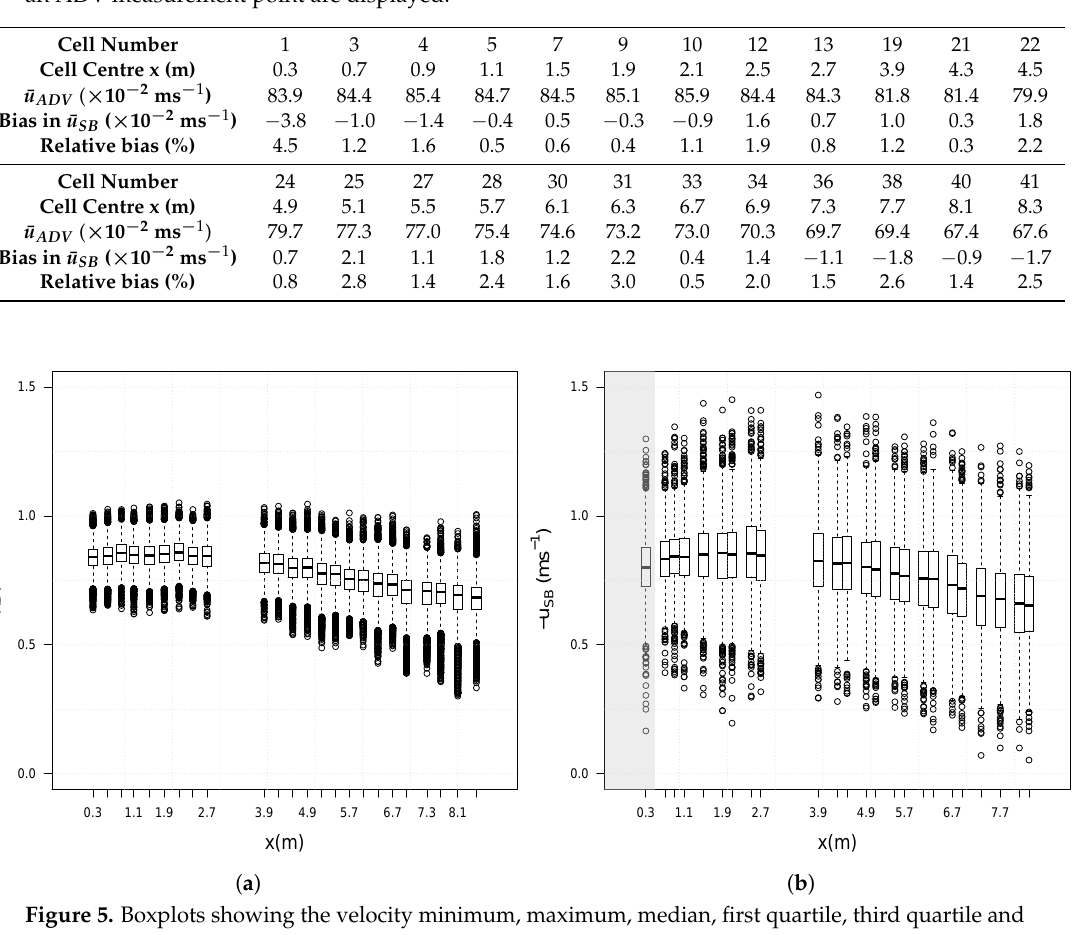
Table 6. Mean velocity measured by the ADV along with the associated absolute bias and relative bias introduced by the SB-ADP for a nominal tank velocity of 0.8 ms − 1 . Only the SB-ADP cells that match an ADV measurement point are displayed.